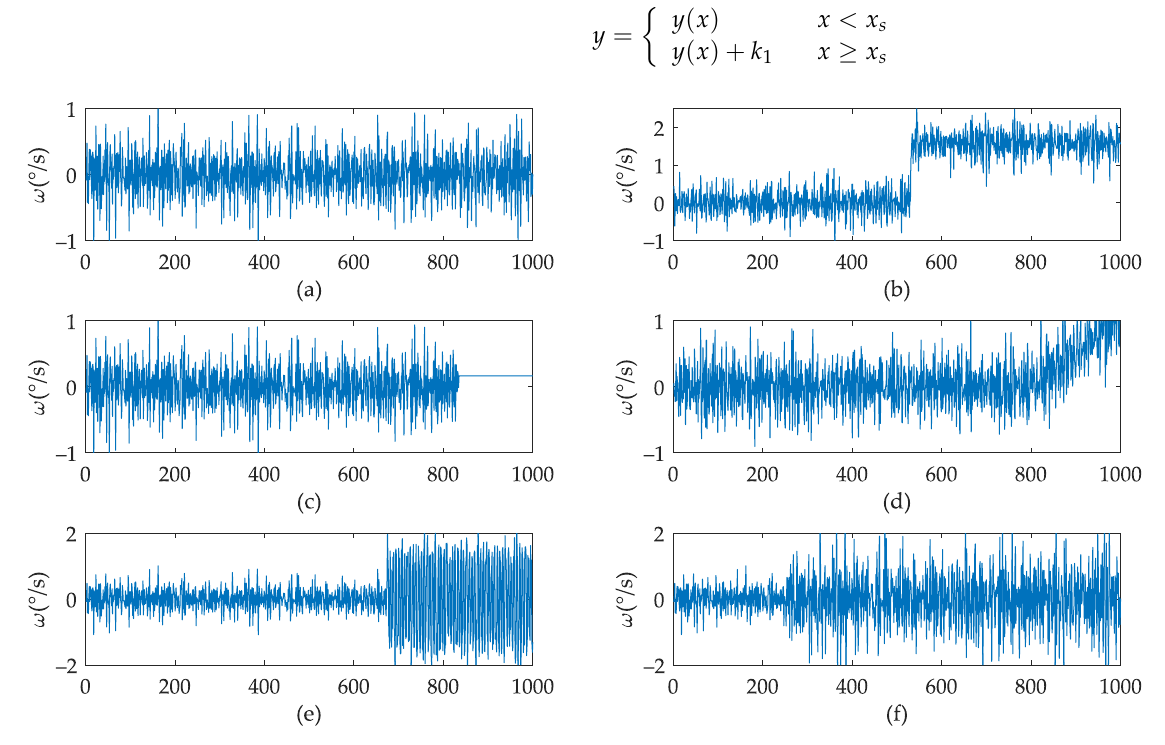
Figure 11. Fault classes of FOG. ( a ) normal data. ( b ) bias fault data. ( c ) blocking fault data. ( d ) drift fault data. ( e ) periodic interference fault. ( f ) multiplicative fault data.